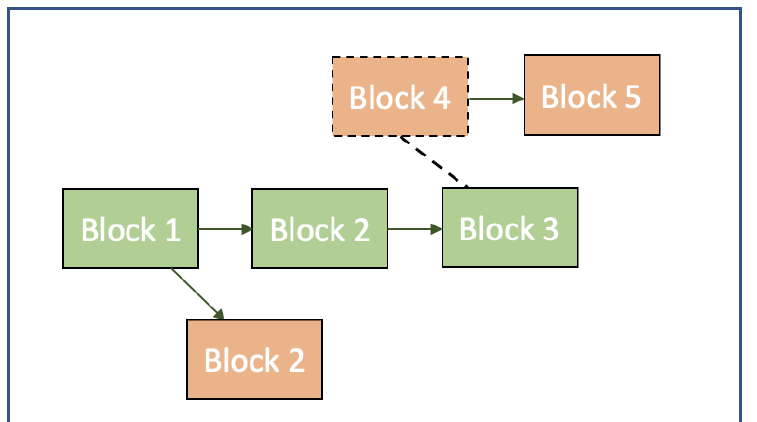
Figure 6. Blockchain forks.